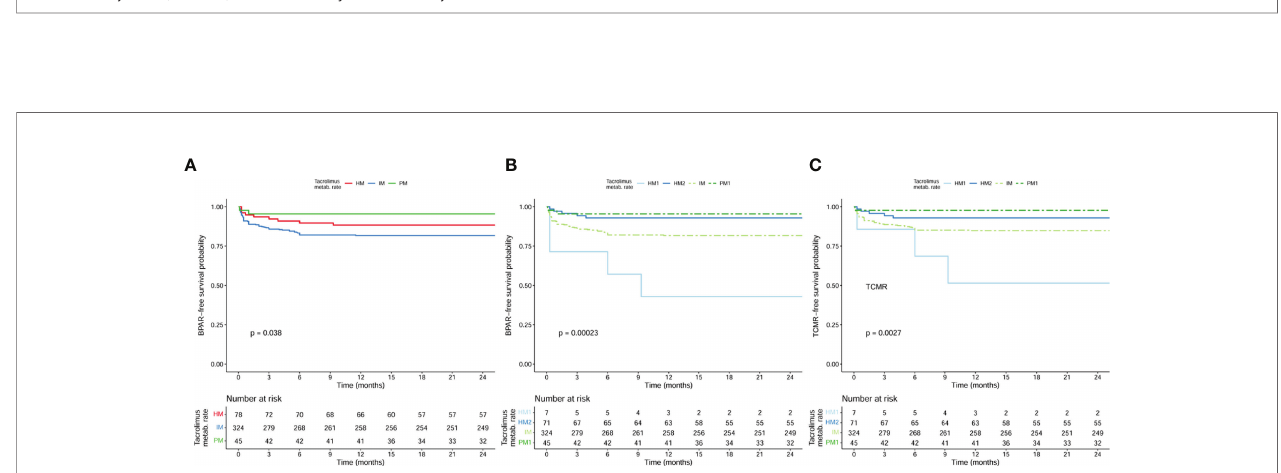
FIGURE 5 | BPAR-free survival curves according to main CYP3A phenotype clusters (HM; IM and PM) (log rank = 0.038) and BPAR-free and TCMR-free survival curves according to the strati fi ed clusters (HM1, HM2, IM, and PM1) (log rank <0.001 and log rank <0.001, respectively) in the whole population (n = 447). (A) Log rank (HM vs IM) = 0.156; log rank (HM vs PM) = 0.202; log rank (IM vs PM) = 0.026. (B) Log rank (HM1 vs HM2) < 0.001; log rank (HM1 vs IM) = 0.007; log rank (HM1 vs PM1) < 0.001; log rank (HM2 vs IM) = 0.023; log rank (HM2 vs PM1) = 0.593; log rank (IM vs PM1) = 0.026. (C) Log rank (HM1 vs HM2) < 0.001; log rank (HM1 vs IM) = 0.031; log rank (HM1 vs PM1) < 0.001; log rank (HM2 vs IM) = 0.077; log rank (HM2 vs PM1) = 0.274; log rank (IM vs PM1) = 0.024. BPAR, biopsy- proven acute rejection; HM, high metabolizers; IM, intermediate; PM, poor metabolizers; TCMR, T cell-mediated